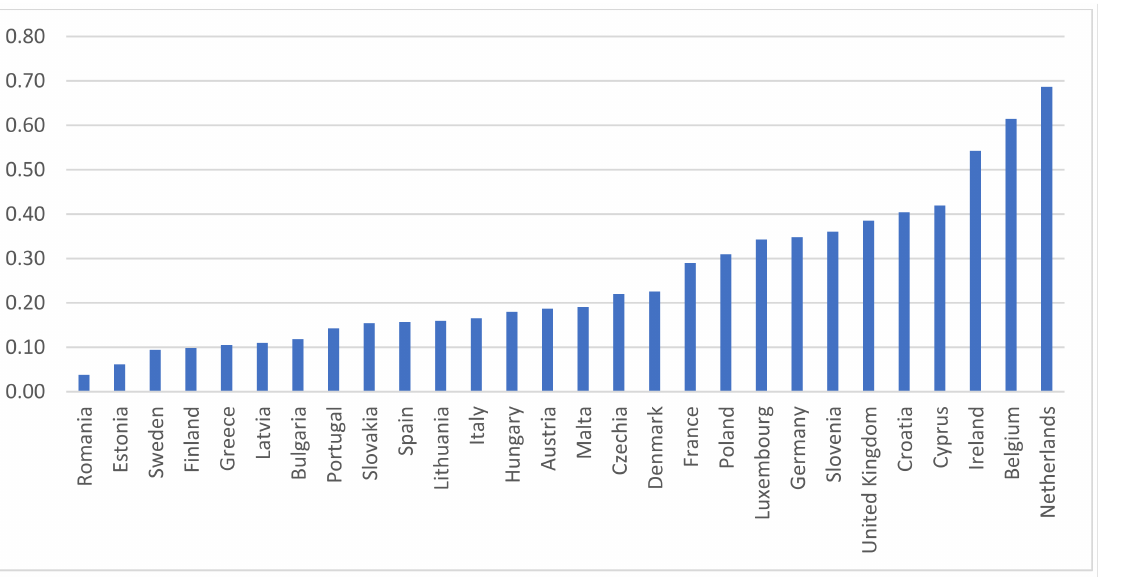
Figure 3. Ranking of EU member states according to agricultural output intensity from 2010 to